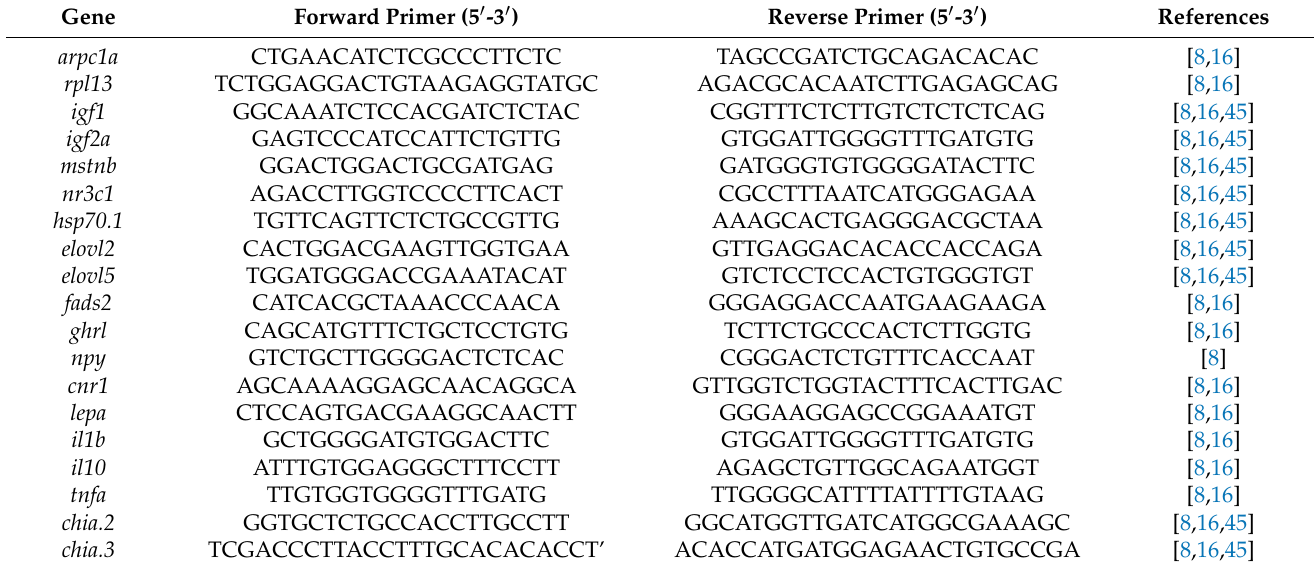
Table 2. Primer sequences used in the present study and ZFIN IDs reported in previous studies. Gene Forward Primer (5 (cid:48) -3 (cid:48) ) Reverse Primer (5 (cid:48) -3 (cid:48)